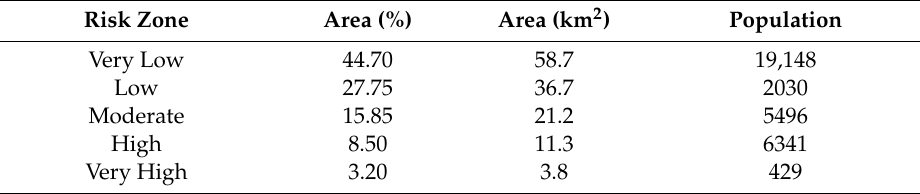
Table 2. Area and population distribution with respect to risk